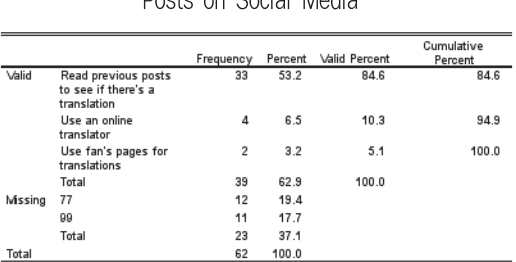
small percentage of fans. <Table 16> Brazilian K-Pop Fans Methods to Try to Understand Their Favourite K-Pop Artists Posts on Social Media